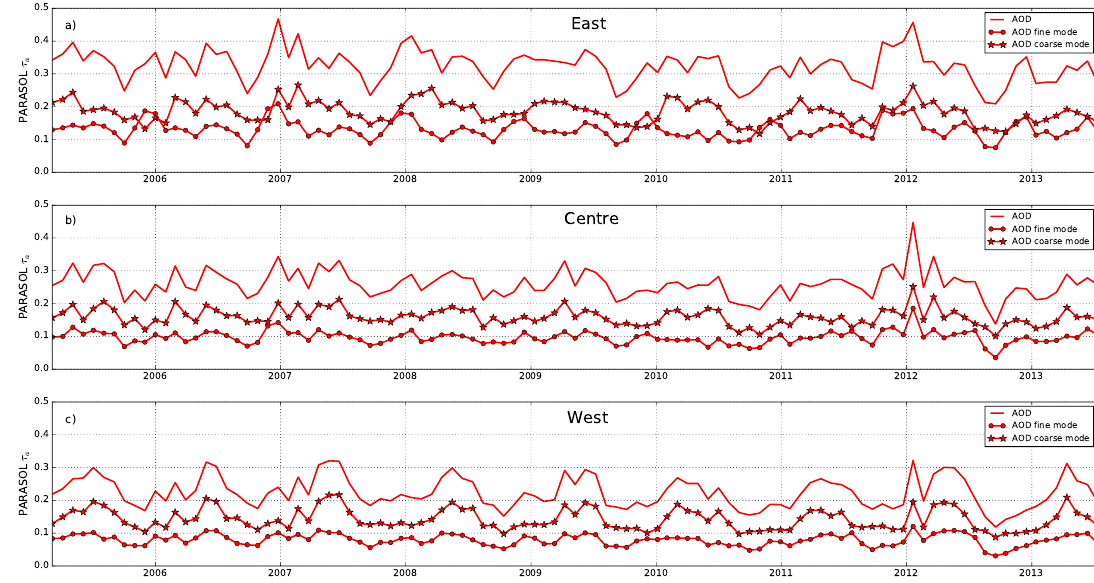
Figure 8. Monthly mean of PARASOL AOD (solid curve), PARASOL AOD f (line-dots) and PARASOL AOD c (line-stars) at 550 nm in ( a ) East zone, ( b ) Centre zone and ( c ) West zone. All plots are averaged from 2005 to